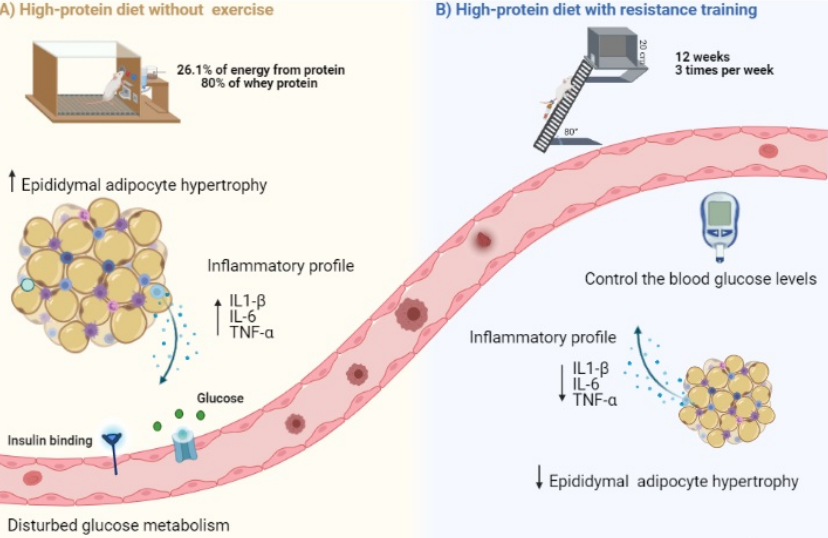
Figure 5. Overview of the effects of high-protein diet and resistance training on glucose control, adipocyte size, and epididymal adipose inflammatory biomarkers in rats. ( A ) High-protein diet without exercise induced epididymal adipocyte hypertrophy and increased TNF-α, MCP-1, and IL1-β levels, which combined may have contributed to disturbed glucose metabolism; ( B ) Resistance exercise training compensated the detrimental effects of high-protein diet by reducing epididymal adipocyte hypertrophy, local inflammation, and glucose blood levels. The figure was created in the Biorender web-based software.